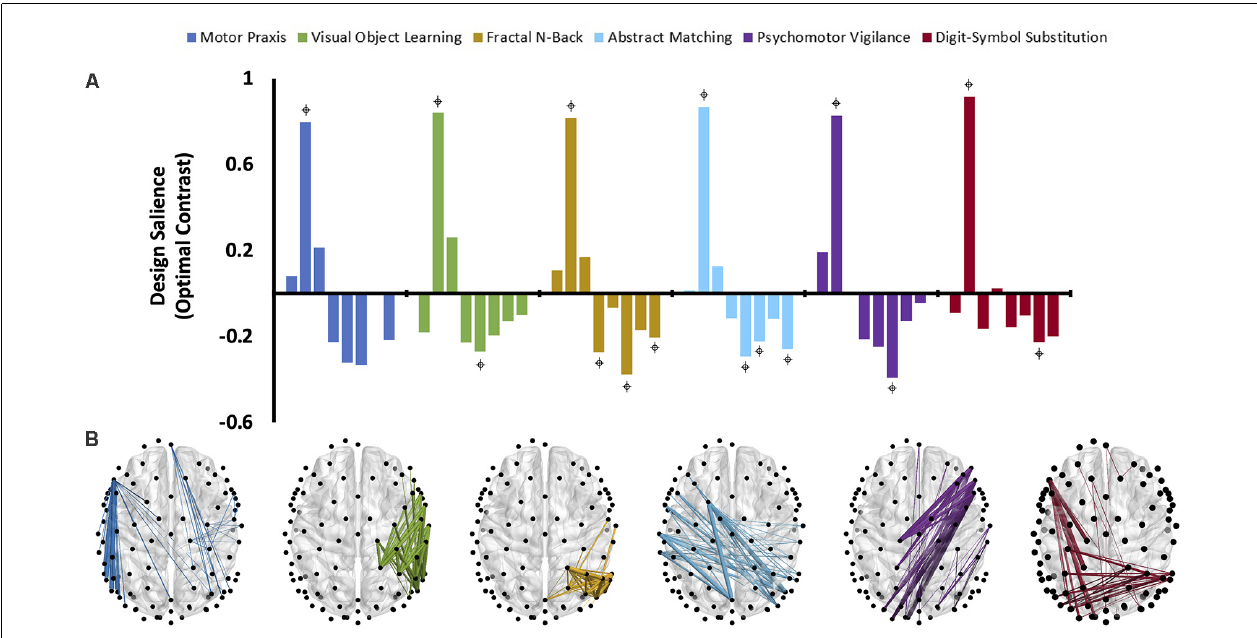
FIGURE 6 | The dominant latent variables (LV = 1 in all cases) capturing the distinct networks of maximal functional connectivity covariance across all eight cognitive testing sessions corresponding to each cognitive task in the theta bandwidth (PLS analysis, variation 3). (A) Design saliences associated with network changes for each cognitive test across all eight sessions, where each bar corresponds to a single cognitive testing session. ⌖ = non-zero bootstrap-estimated 95% confidence interval. Permutation-estimated p -values and proportions of attributable cross block covariance (ES) associated with the significant latent variable are included in Table 2 . (B) The top 1% of connections corresponding to each cognitive test that reliably express the contrast, determined by thresholding the bootstrap